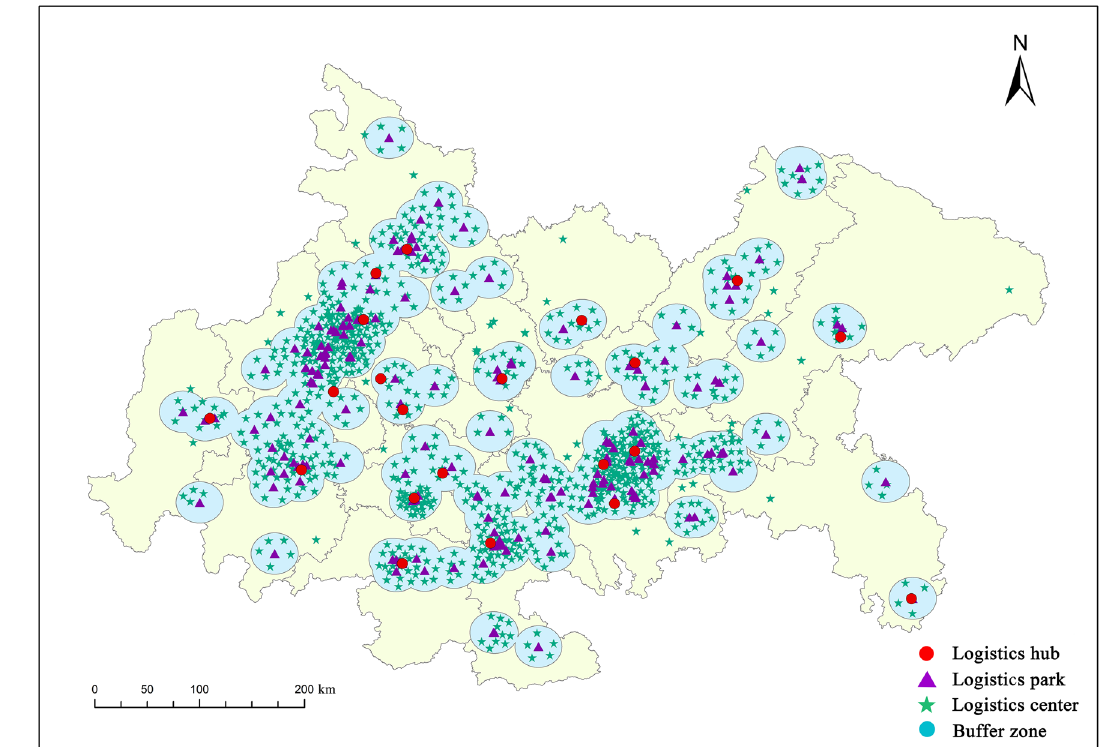
Fig. 3 Distribution of logistics